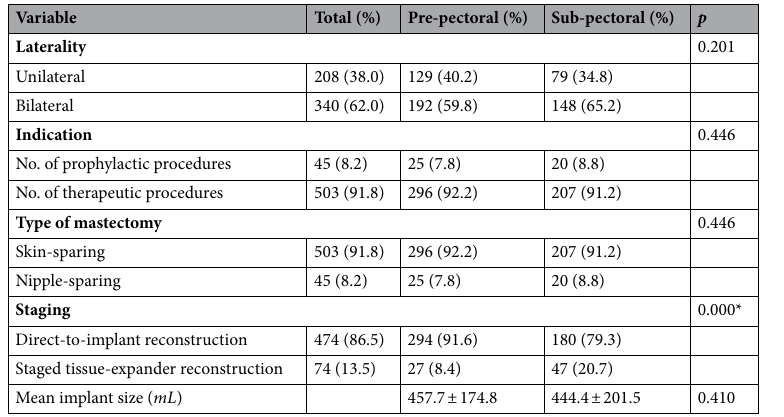
Table 2. Surgical characteristics. This table analyzes the surgical characteristics of the pre-pectoral implant group and the sub-pectoral implant group from the years of 2017 through 2020. The two cohorts differ significantly in terms of reconstructive staging. Continuous variables were analyzed via independent two-tailed t-tests (95% confidence interval) and displayed with standard deviation values. Non-continuous variables were analyzed via Pearson’s chi square. ADM, acellular dermal matrix; ± SD; 95% CI. *Statistically significant ( p <